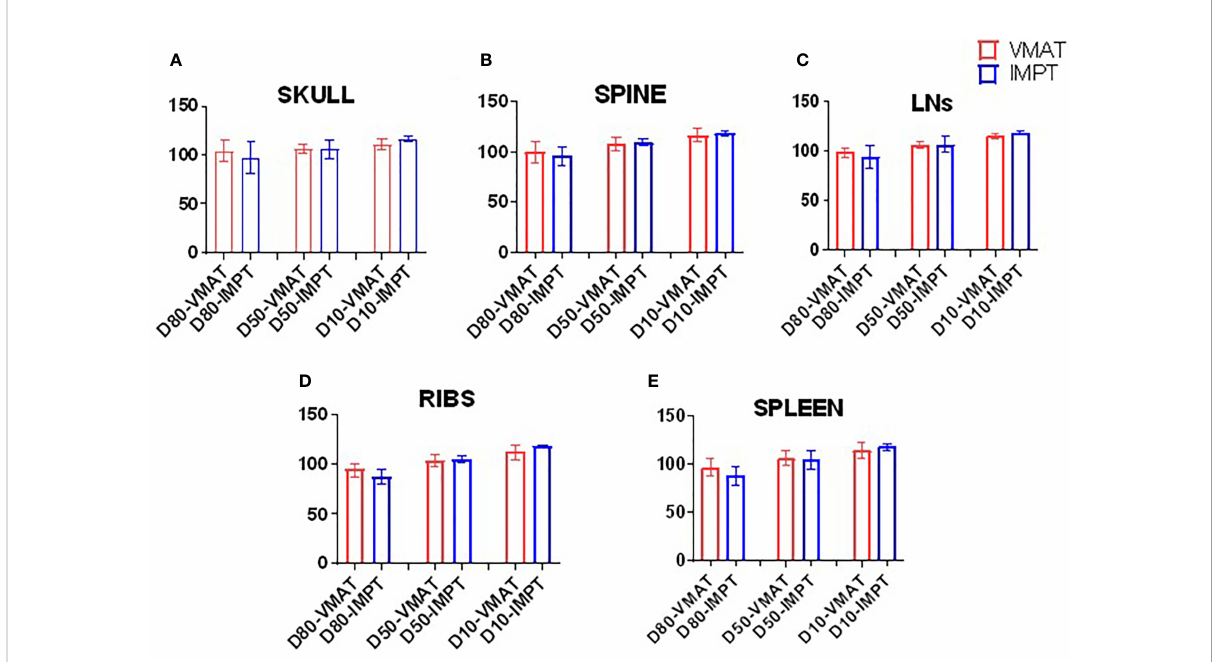
FIGURE 4 Bar graphs of the D80, D50, and D10 of targets. (A) Skull, (B) spine, (C) lymph nodes, (D) ribs, and (E) spleen.